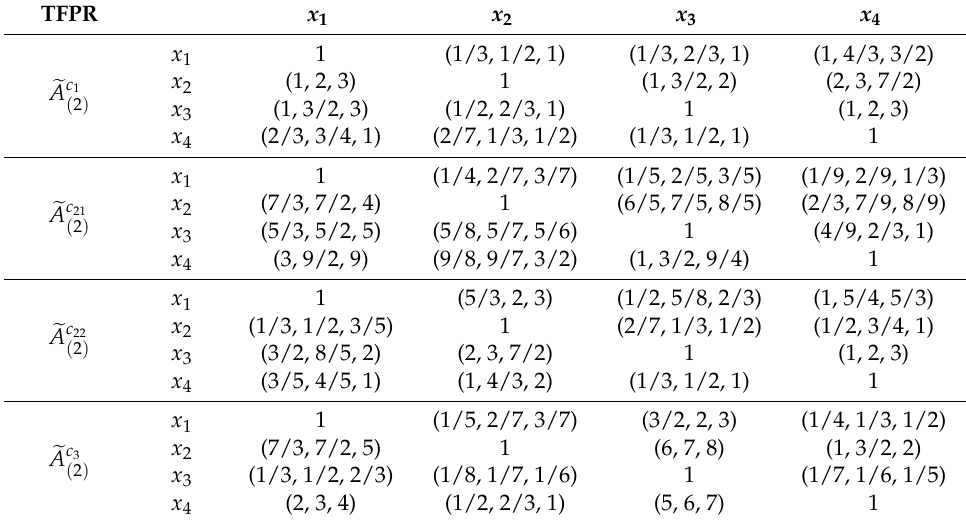
Table 3. Triangular fuzzy judgments provided by the expert e 2 .